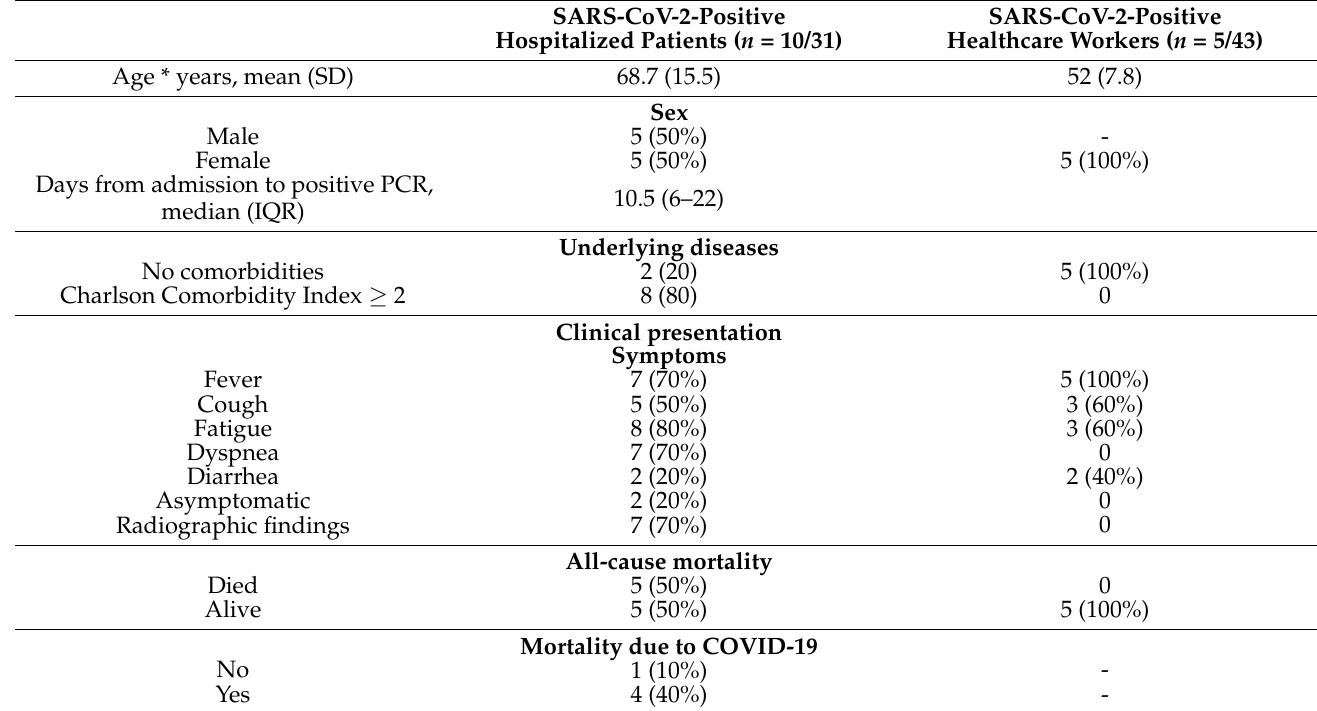
Table 1. Clinical and demographic characteristics of patients and healthcare workers with COVID-19 by disease severity and